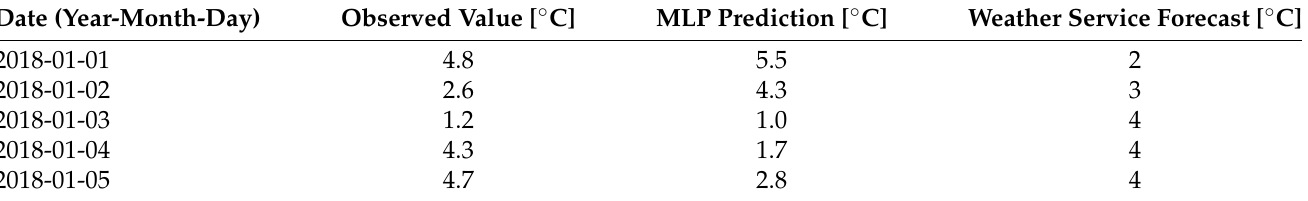
Table A18. Comparison of the MLP and weather service forecast for the minimum temperature.